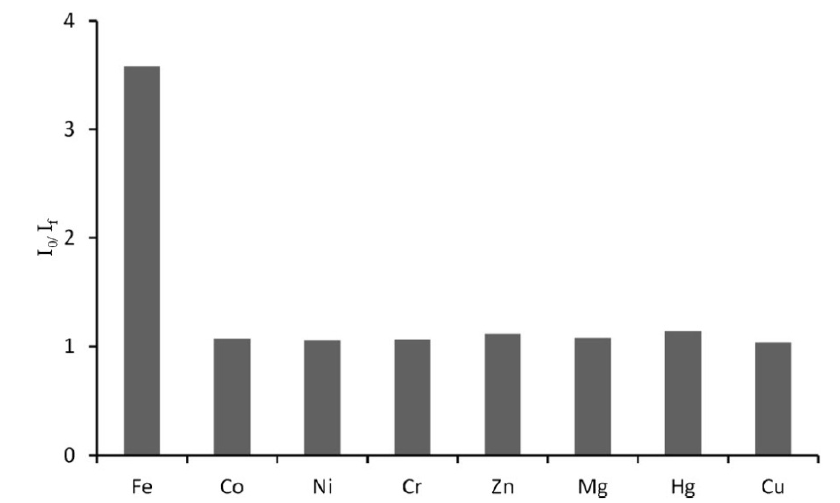
Fig. 15. Bar graphs of the fluorescence emission intensity of SBA-F for Fe 3+ , Cr 3+ , Mg 2+ , Co 2+ , Ni 2+ , Cu 2+ , Hg 2+ and Zn 2+ cations. I corresponds to emission of SBA-F in the absence of metal ions 0